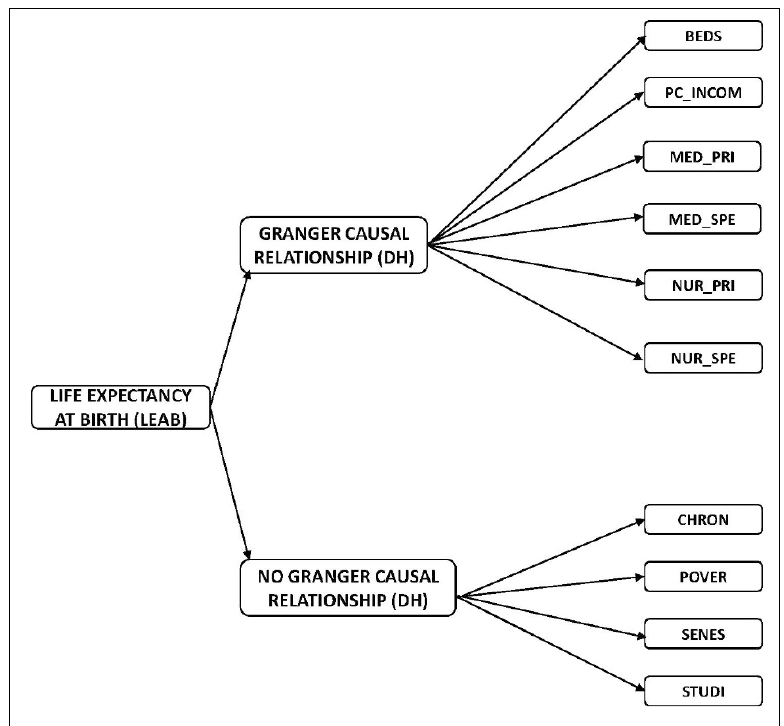
Figure 2. Causal relationships resulting from the causality test for panel data (Dumitrescu–Hurlin version). Source: Own elaboration.